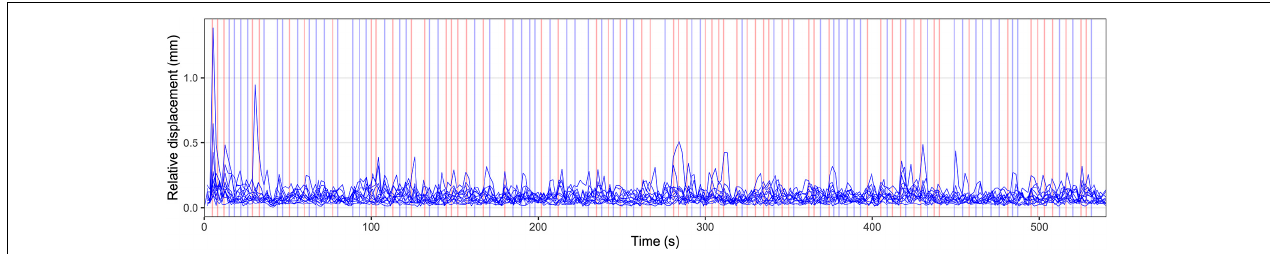
FIGURE 1 | Illustration of the experimental paradigm and individual head motion over time. Relative displacement, the distance between one volume and the following volume, is displayed for all individual participants. Values for relative displacement start after the acquisition of the first brain volume, 1800 ms after the start of the measurement. The presented data represent the head motion before motion correction using volume realignment. The appearance of visual stimuli is marked by vertical lines. Blue vertical lines indicate a German stimulus (“ö” or “che”), red lines indicate an English stimulus (“aw” or “the”). Before the first visual stimulus and after the last visual stimulus rest periods of 5000 ms and 15000 ms duration, respectively, were